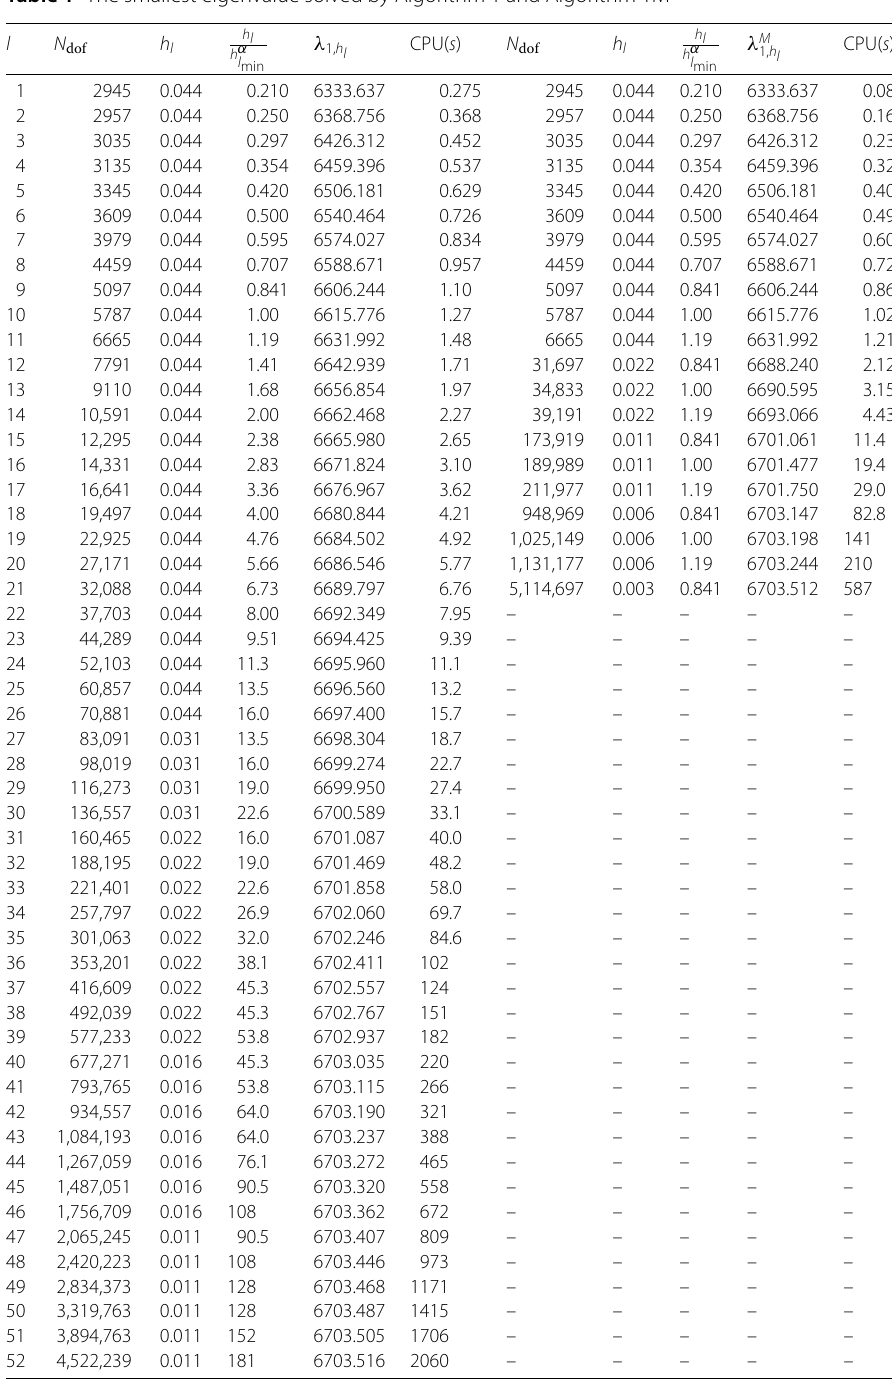
Table 1 The smallest eigenvalue solved by Algorithm 1 and Algorithm